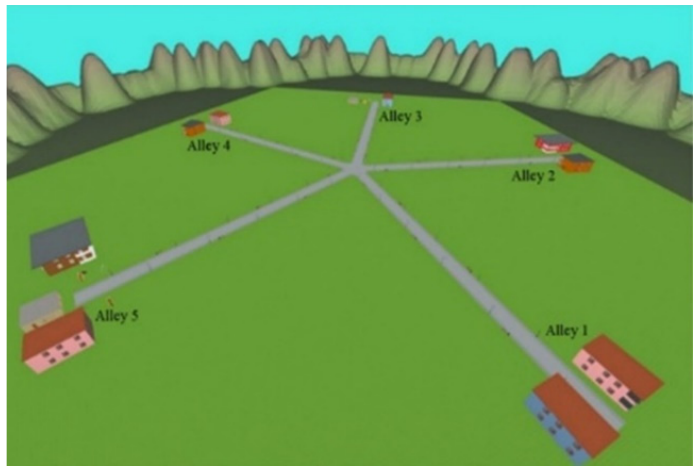
Figure 2. Immersive Virtual Reality scenario: the 5-way maze used for evaluating the navigational Figure 2 . Immersive Virtual Reality scenario: the 5 ‐ way maze used for evaluating the navigational skills at T0 and skills at T0 and T1.